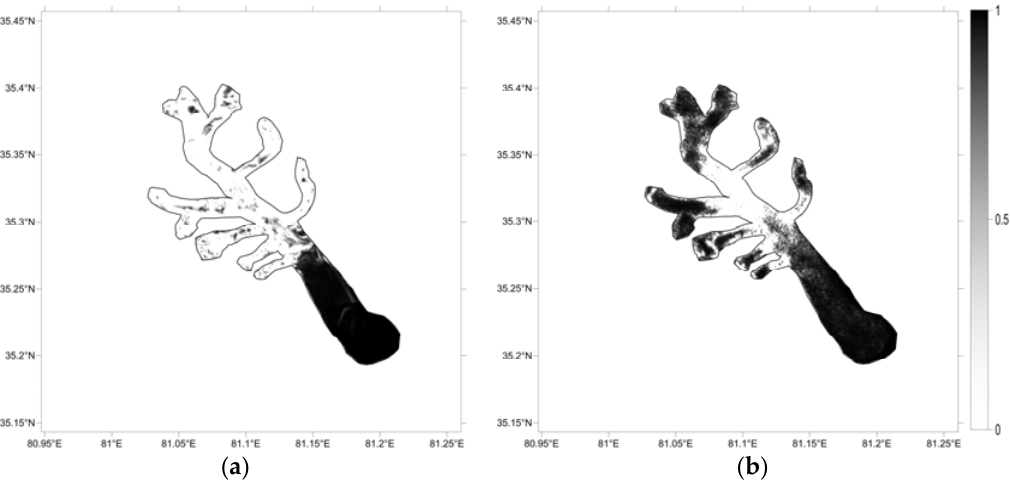
Figure 3. Coherence distribution on the Chongce Glacier. ( a ) Coherence for D-InSAR; ( b ) Coherence for MAI.